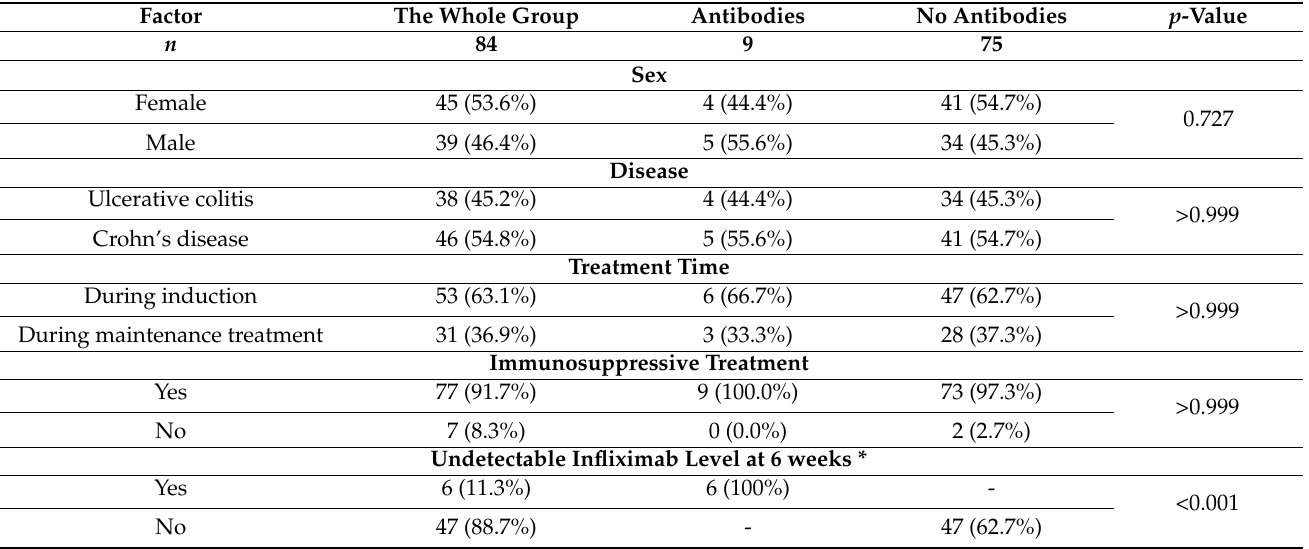
Table 4. Analysis of potential risk factors for the presence of